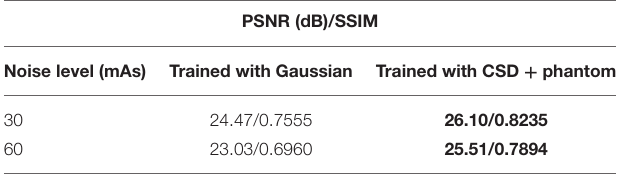
The best results are highlighted in bold.